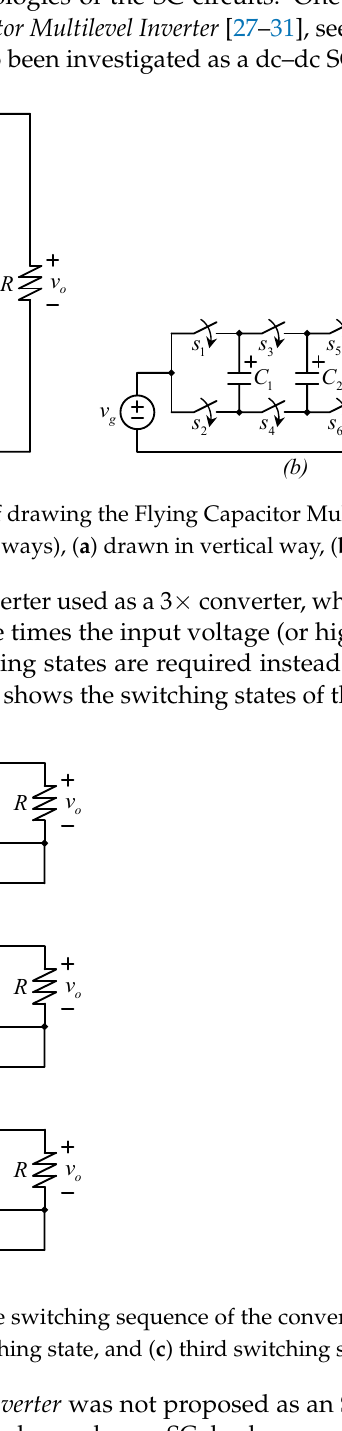
Figure 15. The MMCC Converter topology. The operation can be explained in the following manner: The digital inputs are di- vided into two groups with the same firing signal; similar to the former SC converters, it has two equivalent circuits (except for the flying capacitor, which has three). Figure 16a shows the first equivalent circuit; in this state, switches s 1 , s 3 , s 4 , s 7 , s 9 , s 11 , and s 13 are on, while s 2 , s 5 , s 6 , s 8 , s 10 , and s 12 are off. Figure 16b shows the second equivalent circuit; in this state, switches s 1 , s 3 , s 4 , s 7 , s 9 , s 11 , and s 13 are off, while s 2 , s 5 , s 6 , s 8 , s 10 , and s 12 are on.